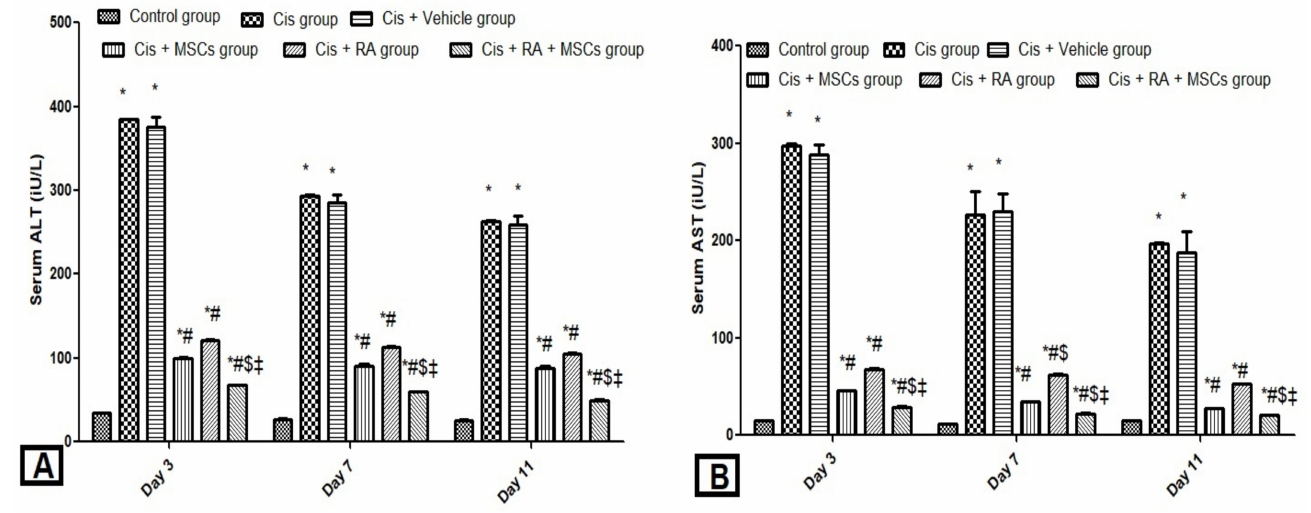
Figure 2. Serum levels of liver enzymes: ALT ( A ) and AST ( B ) (iU/L) in different studied groups. All data are expressed as Mean ± SD. One-way ANOVA with Tukey post hoc test. * Significant vs. control group, # significant vs. Cis group, ‡ significant vs. Cis + BM-MSCs group and $ significant vs. Cis + RA group. ALT = alanine transaminase and AST = aspartate transaminase, Cis = cisplatin, RA = retinoic acid and BM-MSCs = bone marrow derived mesenchymal stem cells. p < 0.05 is considered